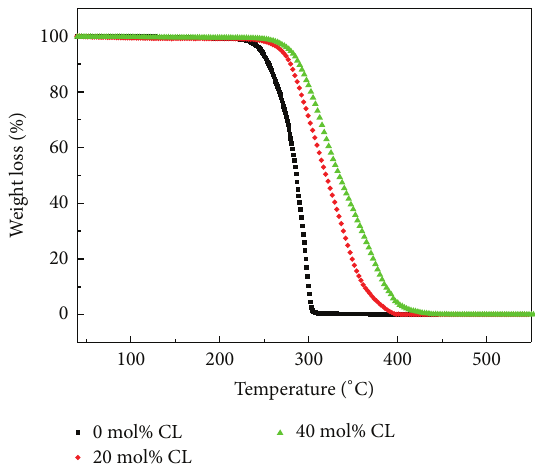
Figure 3: The TGA thermograms of PLGC